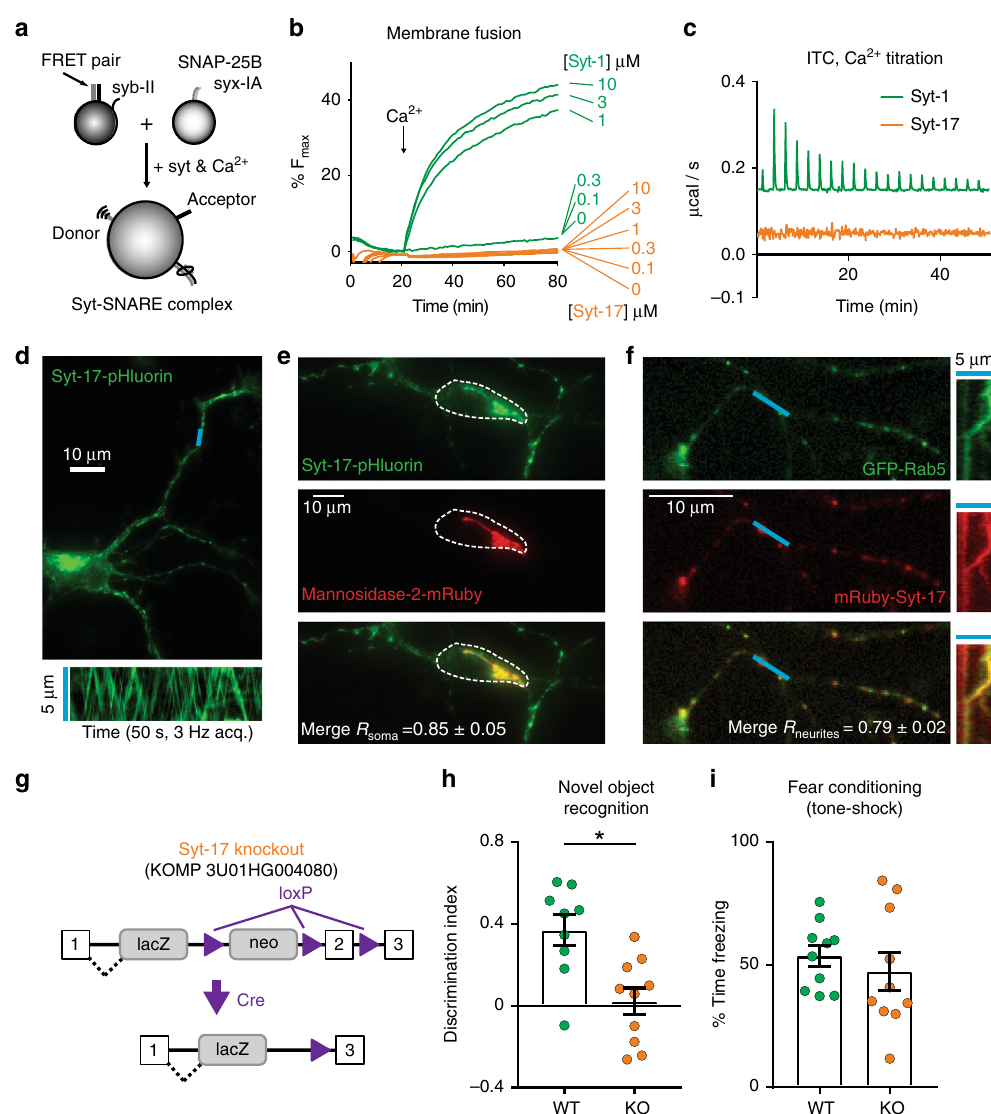
Fig. 1 Syt-17 does not trigger membrane fusion or bind Ca 2 + , localizes to the Golgi and early endosomes, and knockouts exhibit hippocampal-dependent memory de fi cits. a Schematic of the fusion assay. b Syt-1 (green) and syt-17 (orange) protein titration in the fusion assay. “ C2AB ” indicates that the tandem C2 domains of syt-1 or syt-17 were used for experiments. Syt-17, in contrast to syt-1, is unable to stimulate fusion at all protein concentrations tested. c Heat of Ca 2 + binding to isolated C2AB domains of syt-1 and syt-17 as measured by isothermal titration calorimetry. Note the lack of appreciable binding by syt-17. d Top: 3 DIV hippocampal neuron expressing syt-17-pHluorin. Scale bar indicates 10 μ m. Bottom: Kymograph of linescan indicated in blue. Syt- 17-pHluorin puncta are highly mobile and traf fi c bidirectionally. e Syt-17-pHluorin coexpressed with the Golgi marker mannosidase-2-mRuby. Colocalization (Pearson ’ s): 0.85 ± 0.05. Soma indicated with a dashed line. f Left: mRuby-syt-17 coexpressed with GFP-Rab5. Colocalization (Pearson ’ s): 0.79 ± 0.02. Right: Kymograph of indicated linescan, showing co-traf fi cking of syt-17/Rab5. Measurements from fi ve independent preparations, 3 – 8 FOVs/ prep. g Schematic of the genetic strategy. Intron 2 and the fl oxed Neo cassette were excised by performing a cross with a germline-expressing Cre mouse, resulting in nonsense-mediated degradation of the transcript. h Six-week-old mice of either gender, from > 3 breeding lines, were subject to a novel object recognition task, a test of hippocampal-dependent memory. Syt-17 KO showed signi fi cantly impaired performance relative to WT ( t 17 = 3.518, p = 0.003, r 2 = 0.421, Discrimination index mean = 0.37 ± 0.08, mean = 0.02 ± 0.06, N = 9 and N = 10 animals). Syt-17 KO data points are depicted in orange wt ko wt ko and WT in green in all fi gures. i No difference was observed between WT and KO mice in hippocampal-independent paired tone-shock fear conditioning ( p > 0.1, two-sample t -test). Error bars indicate